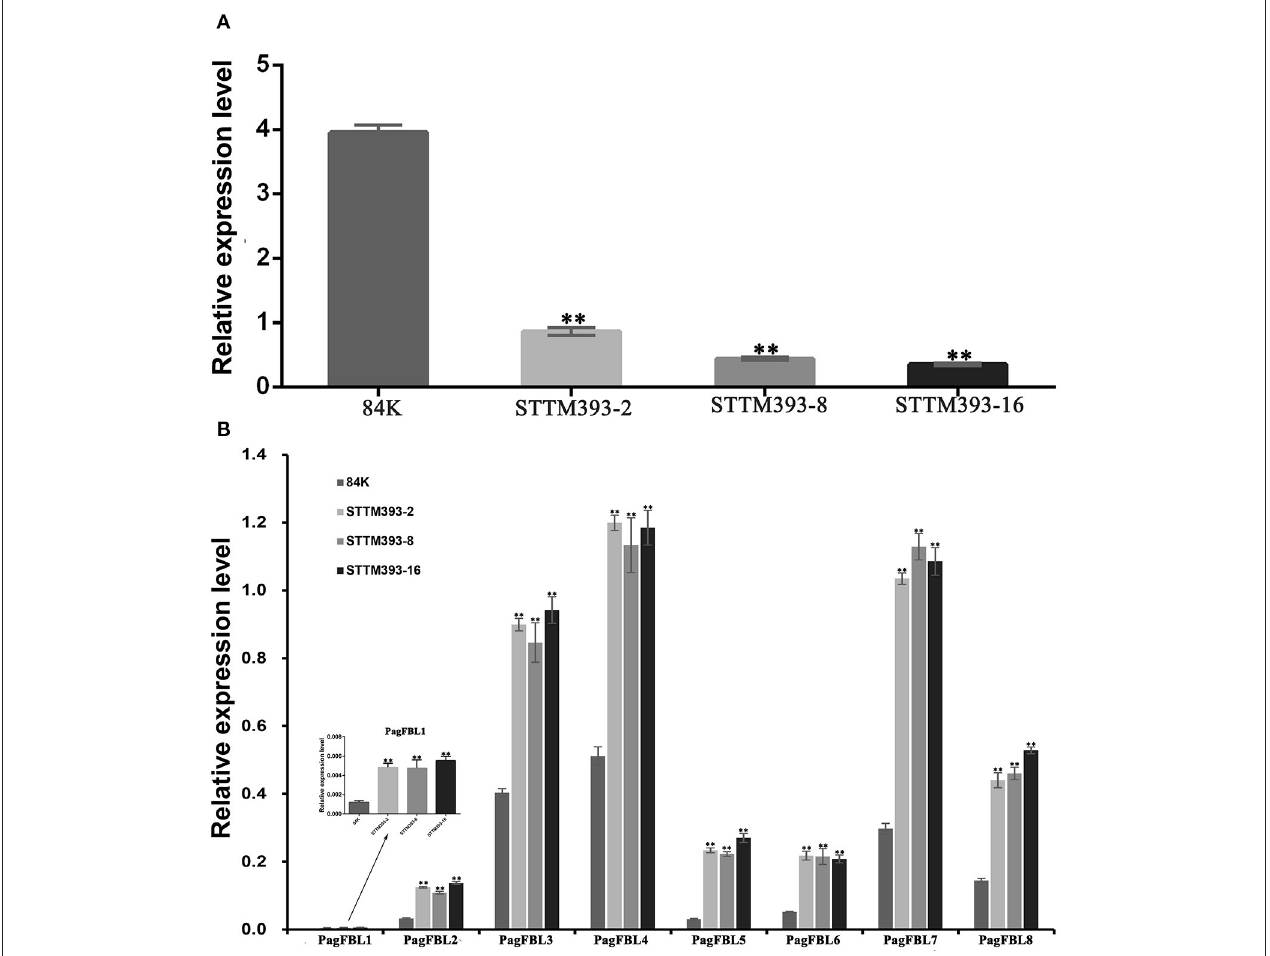
FIGURE 4 | The expression of miR393 and PagFBLs in STTM393 lines by quantitative real-time reverse transcription (qRT)-PCR. The relative expression of miR393 (A) and eight members from PagFBL family (B) was detected by qRT-PCR in the 3-month-old STTM393 lines and 84K control plants. ** P ≤